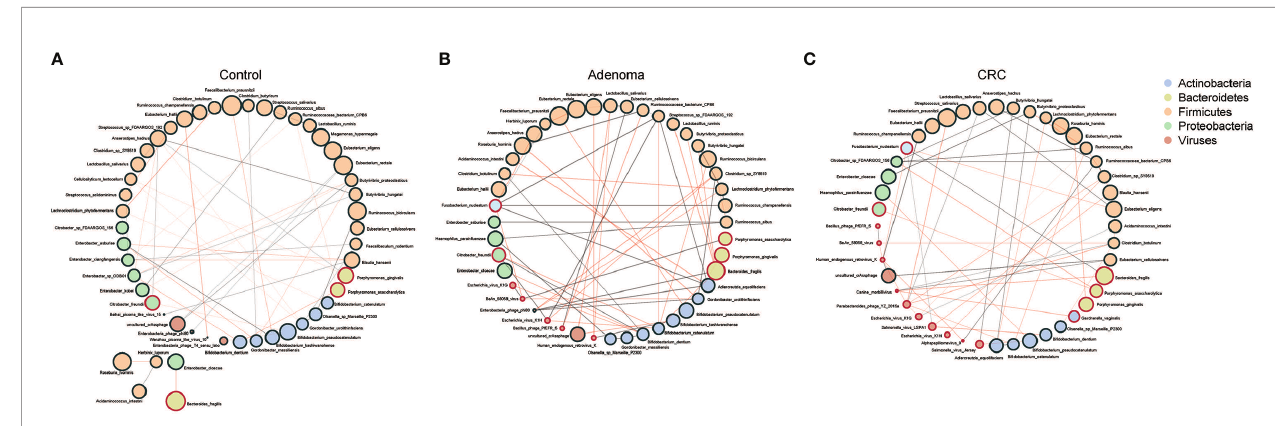
FIGURE 3 | Co-occurrence networks of the marker species in the control (A) , adenoma (B) , and CRC (C) groups. Each microbial species is marked by its af fi liating phylum, which is shown in the top right. A microbial species and cooccurrence relationship are indicated by a node and an edge, respectively. A connection (line between dots) indicates a signi fi cant (FDR < 0.05) correlation. The size of each node is proportional to the relative abundance of the species. Lines between nodes indicate positive correlations (green) or negative correlations